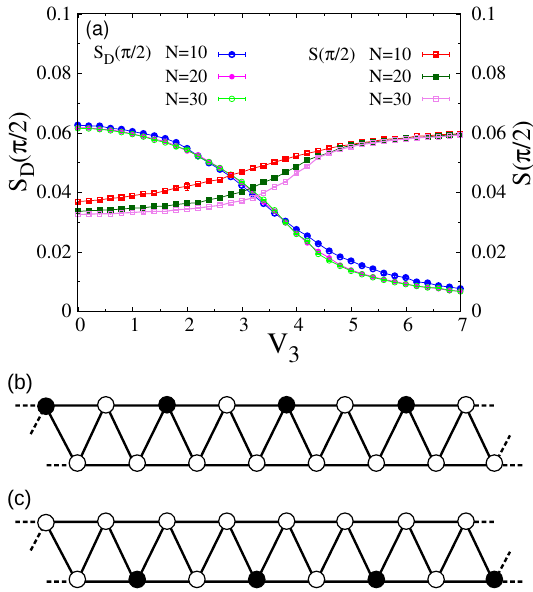
) and structure factor S ( π ( π D 2 = 5.0 and V = 4.0. (b-c) Schematic diagram of 1 2